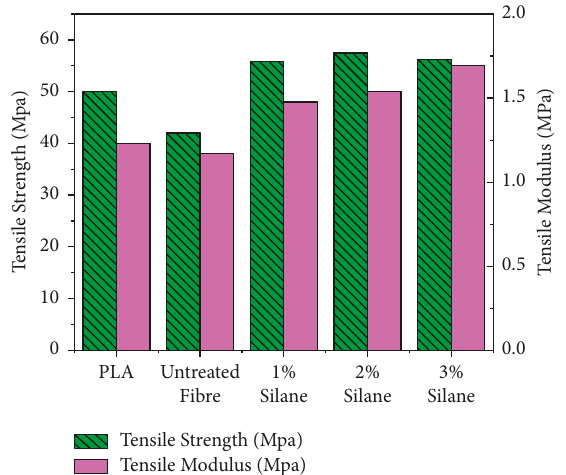
Figure 3: Flexural strength (MPa) and flexural modulus (MPa). Figure 2: Results of composites tensile strength, MPa, and tensile